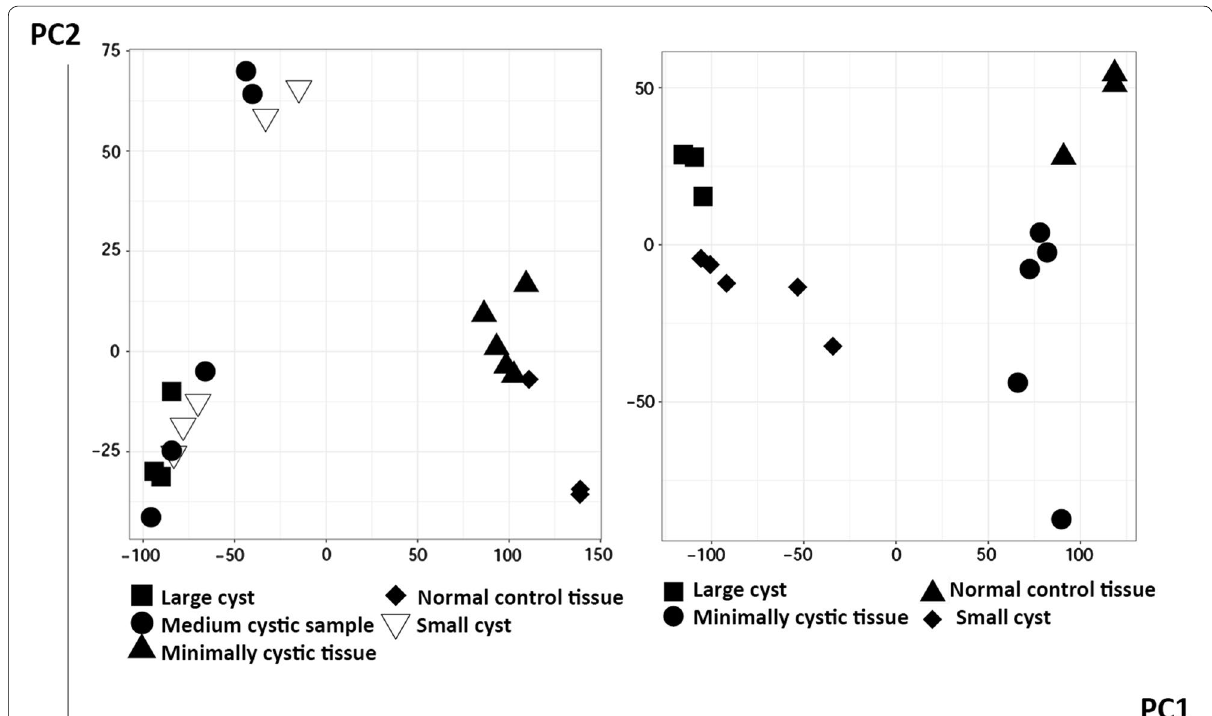
Fig. 1 The quality of the microarray dataset is satisfying. The Principle component analysis results of the GSE7869 dataset were shown the samples were separated